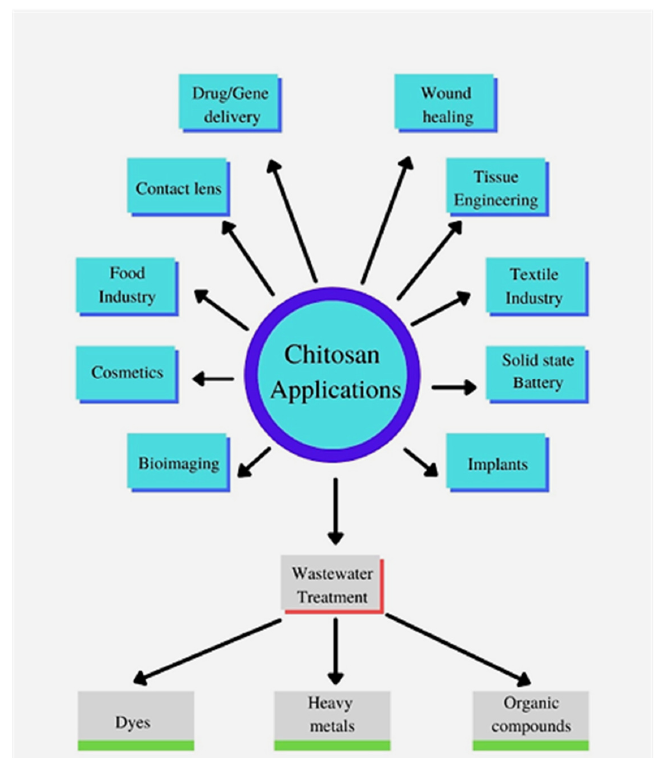
Figure 1. Figure 1.Figure 1. Figure 1. Applications of chitosan in various